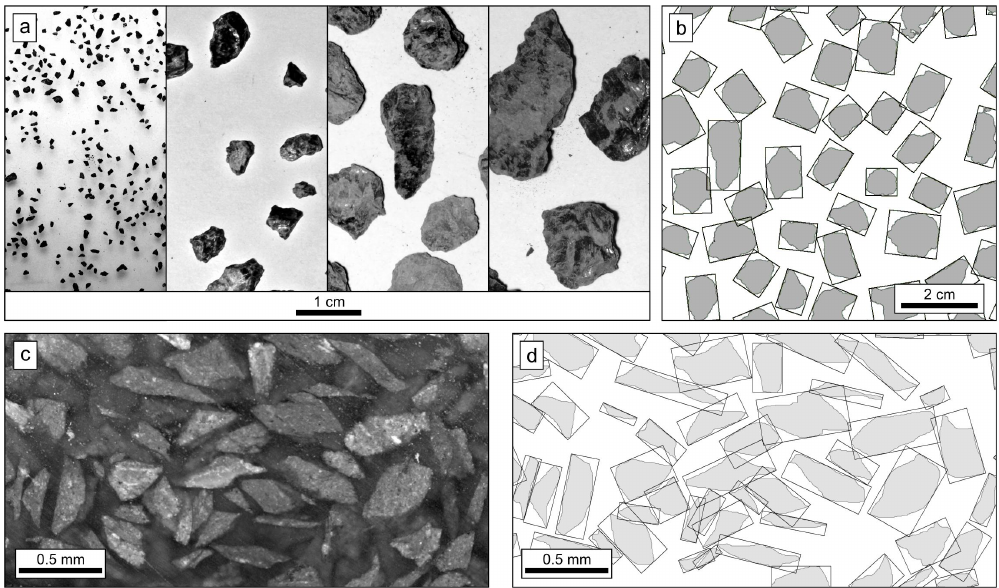
Figure 7. Disintegrated microlithons ( a and c ) and corresponding DIA segmentations with minimum bounding rectangles for shape de- scription ( b and d ). (a) Photographs of dispersed microlithons of different sieve fractions. (c) is a reflected light micrograph showing resin- embedded microlithons from the 800 to 400µm sieve fractions. See text for